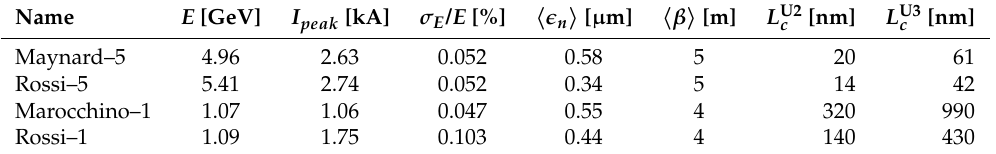
Table 3. Best slice values of the relevant parameters at undulator entrance and of the expected cooperation lengths, at the specified undulator